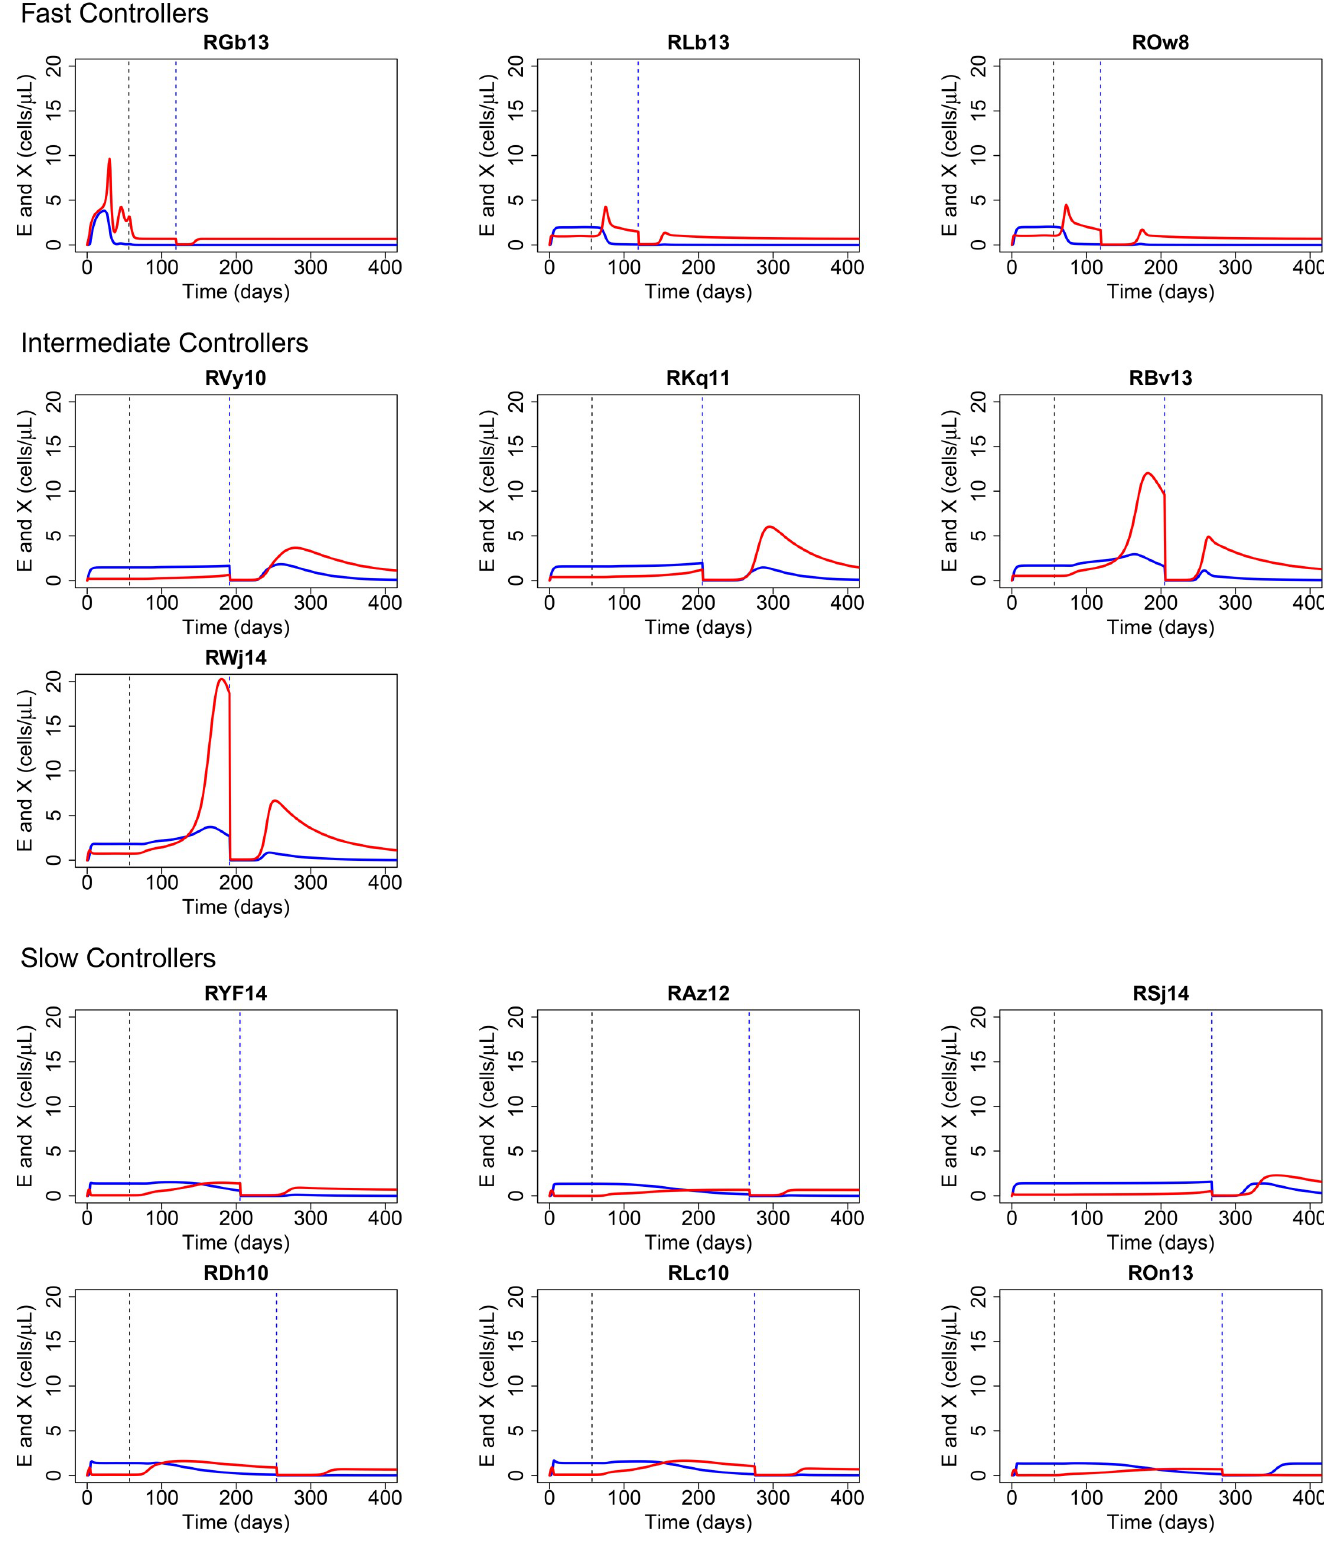
Fig 4. Simulations of effector cell (red lines) and exhausted cell (blue lines) dynamics in the CTL-VC model. The first vertical dashed line indicates the start time of ART, and the second vertical dashed line indicates the time of anti-CD8 antibody administration. https://doi.org/10.1371/journal.ppat.1007350.g004 PLOS Pathogens| https://doi.org/10.1371/journal.ppat.1007350 October 11,